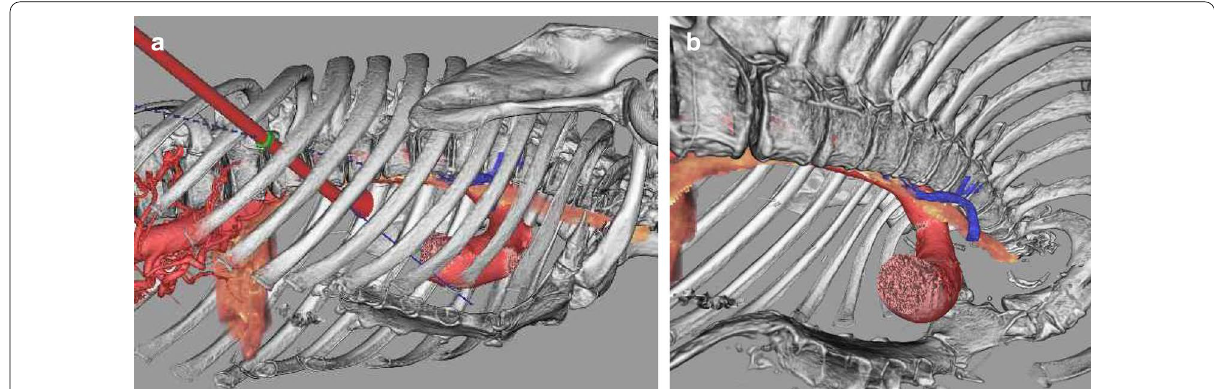
Fig. 5 a 3D-CT image created by contrast-enhanced CT images in the supine position. b 3D-CT imaging revealed difficulty in ensuring the surgical field